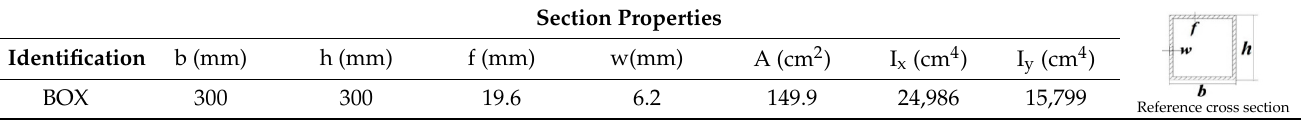
Table 5. Sectional properties of selected box section steel column for calculation examples.